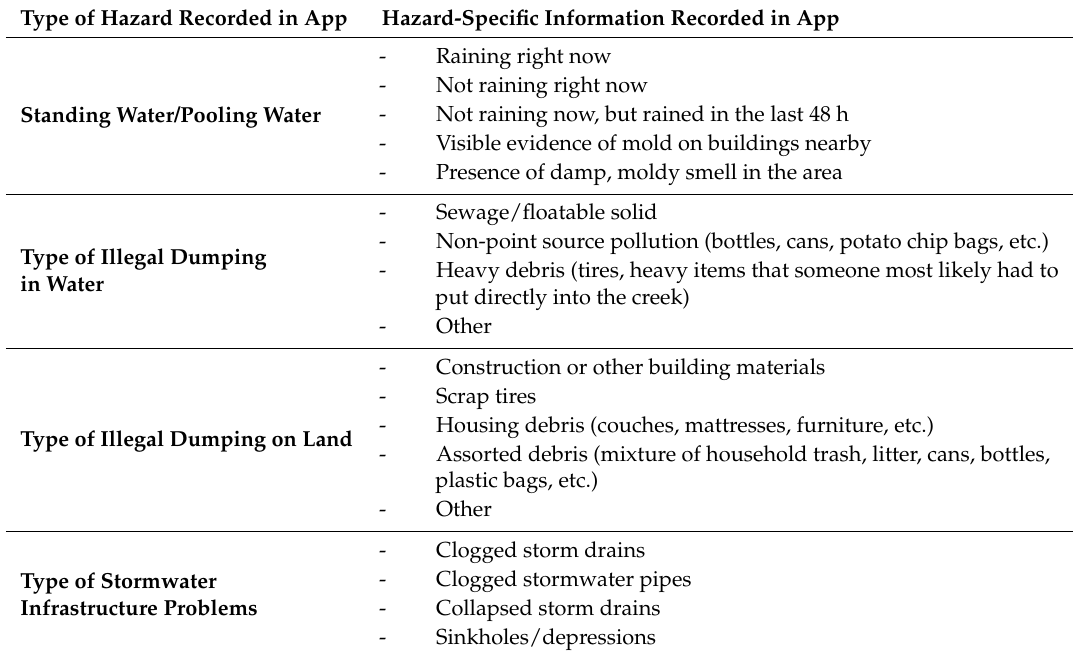
Table 1. Hazard-specific data choices from drop-down menus collected in the Proctor Creek Watershed Citizen Science